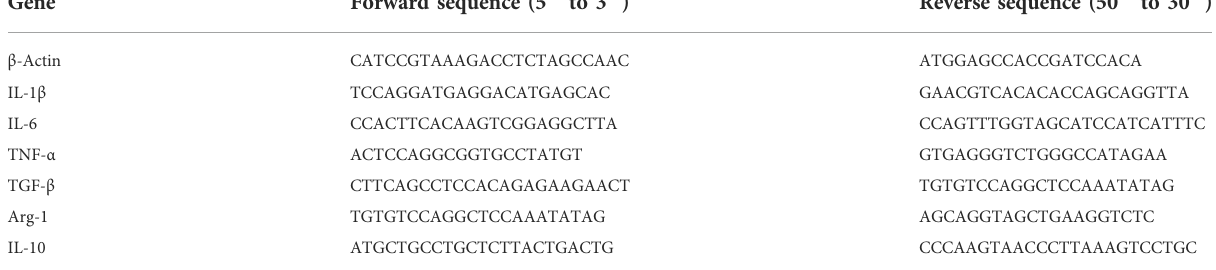
TABLE 1 Primer sequences used in this